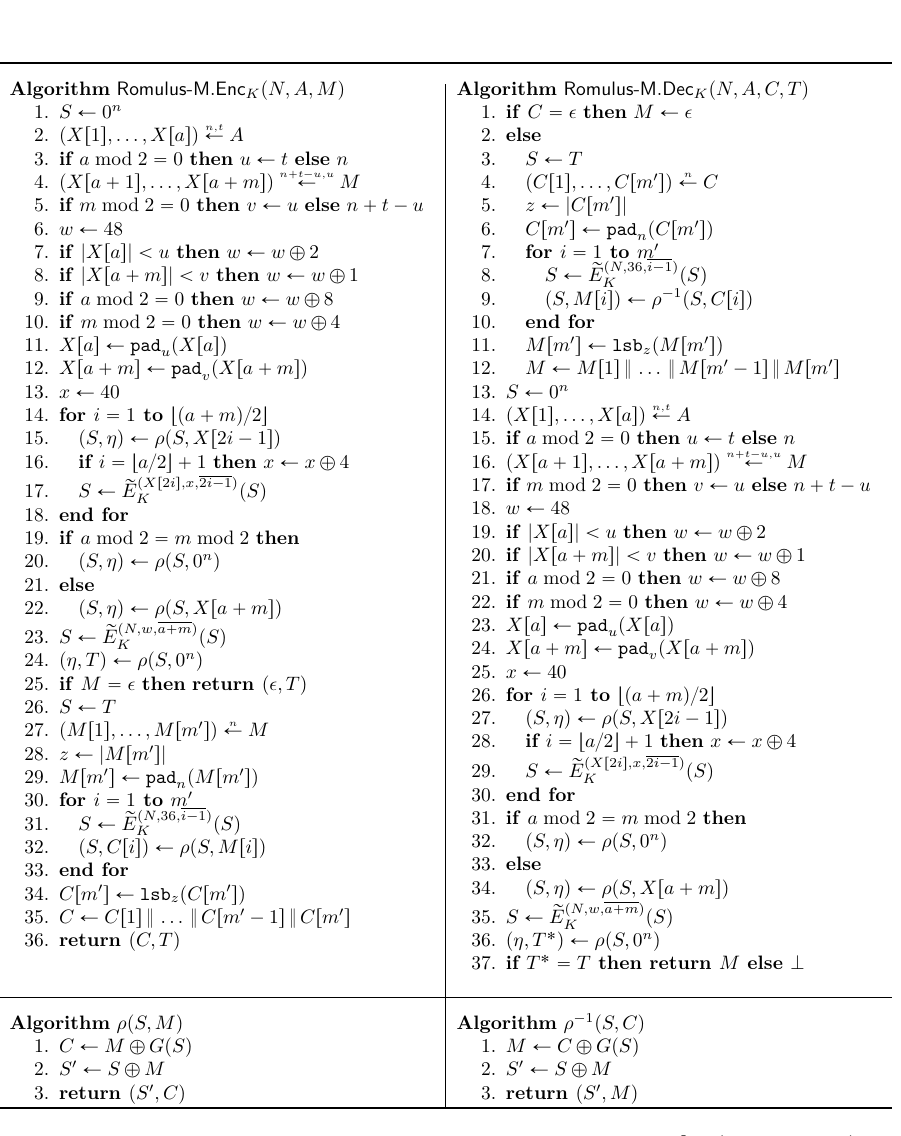
Figure 4: The Romulus-M misuse-resistant AE mode. Lines of [if (statement)